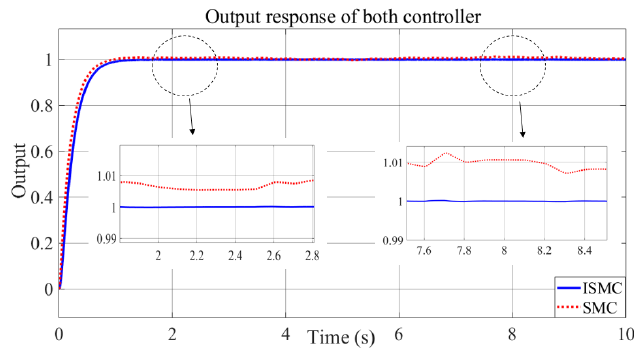
Figure 7. Trajectory tracking of both control schemes.